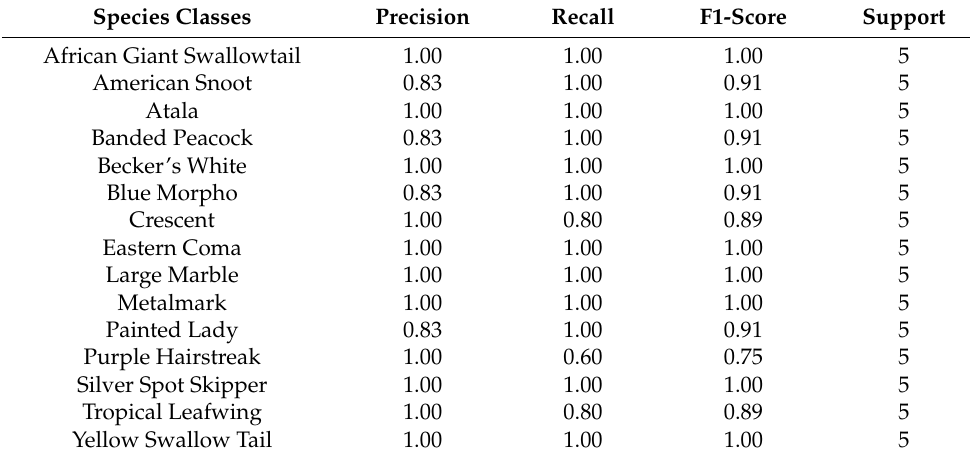
Table 4. Precision, Recall, F1-Score of Inception V3 model with data